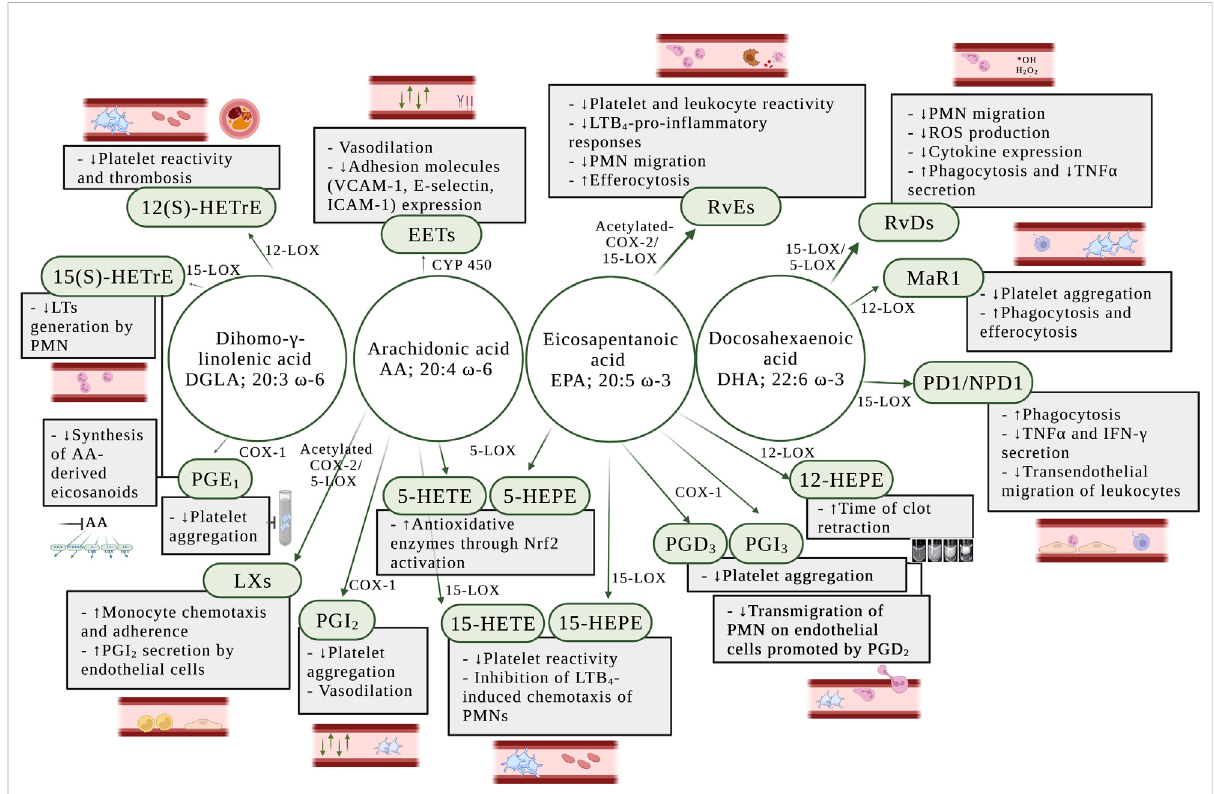
FIGURE 4 Anti-in fl ammatory effects of eicosanoids in the blood and the vessel wall. AA: arachidonic acid; DGLA: dihomo- γ -linolenic acid; DHA: docosahexaenoic acid; EETs: epoxyeicosatrienoic acids; EPA: eicosapentaenoic acid; COX: cyclooxygenase; COX-1: cyclooxygenase-1; COX-2: cyclooxygenase-2; CYP450: cytochrome epoxygenase; ICAM-1: intercellular adhesion molecule 1; IFN- γ : interferon- γ ; LTs: leukotrienes; LTB 4 : leukotrieneB 4 ; LXs: lipoxins; MaR1: maresin 1; Nrf2: nuclear factor-erythroid factor 2-related factor 2; PD1/NPD1: protectin D1/neuroprotectin D1; PGD 2 : prostaglandin D 2 ; PGD 3 : prostaglandin D 3 ; PGE 1 : prostaglandin E 1 ; PGI 2 : prostaglandin I 2 or prostacyclin; PGI 3 : prostaglandin I 3 ; PMN: polymorphonuclear leukocytes; RvDs: D-series resolvins; RvEs: E-series resolvins; ROS: reactive oxygen species; TNF α : tumor necrosis factor α ; VCAM-1: vascular cell adhesion molecule 1; 12-HEPE : 12-hydroxyeicosapentaenoic acid; 15-HEPE : 15-hydroxyeicosapentaenoic acid; 5-HETE: 5 - hydroxyeicosatetraenoic acid; 5-LOX: 5-lipoxygenase; 12-LOX: 12-lipoxygenase; 12(S)-HETrE: 12(S)-hydroxyeicosatrienoic acid; 15-LOX: 15- lipoxygenase; 15-HEPE : 15(S)-hydroxyeicosapentaenoic acid; 15-HETE: 15 (S)-hydroxyeicosatetraenoic acid; 15(S)-HETrE: 15(S)- hydroxyeicosatrienoic